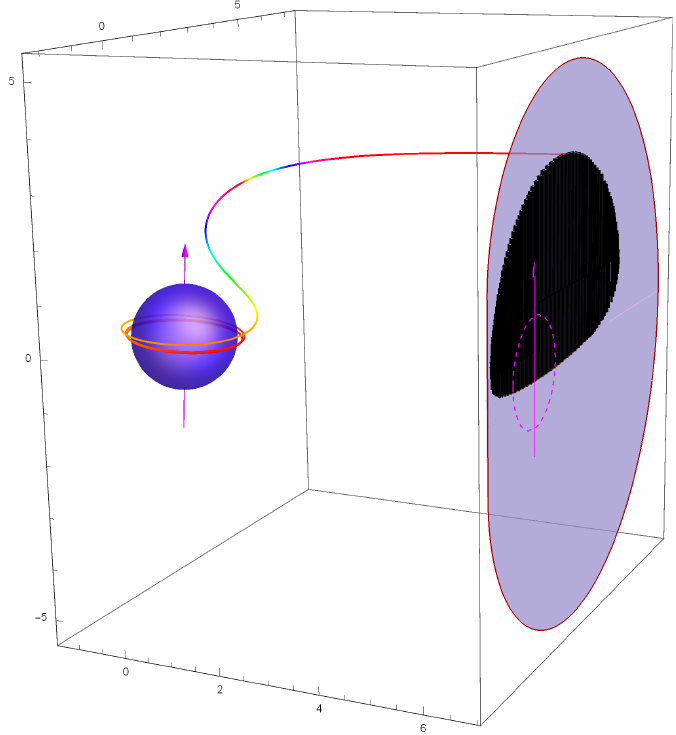
Figure 7. A visible dark silhouette of the northern hemisphere of the event horizon (black region) illuminated by a thin accretion disk in the equatorial plane of the black hole with the spin a = 0.9982, corresponding to the orientation of supermassive black hole SgrA* with respect to a distant observer. The outline (contour) of this silhouette is defined by the highly red-shifted photons, emitted near the black hole event horizon by the thin accreting disk and registered by a distant observer. The photon trajectory is shown (multicolored 3D curve), producing the north pole point on the outline of the event horizon dark